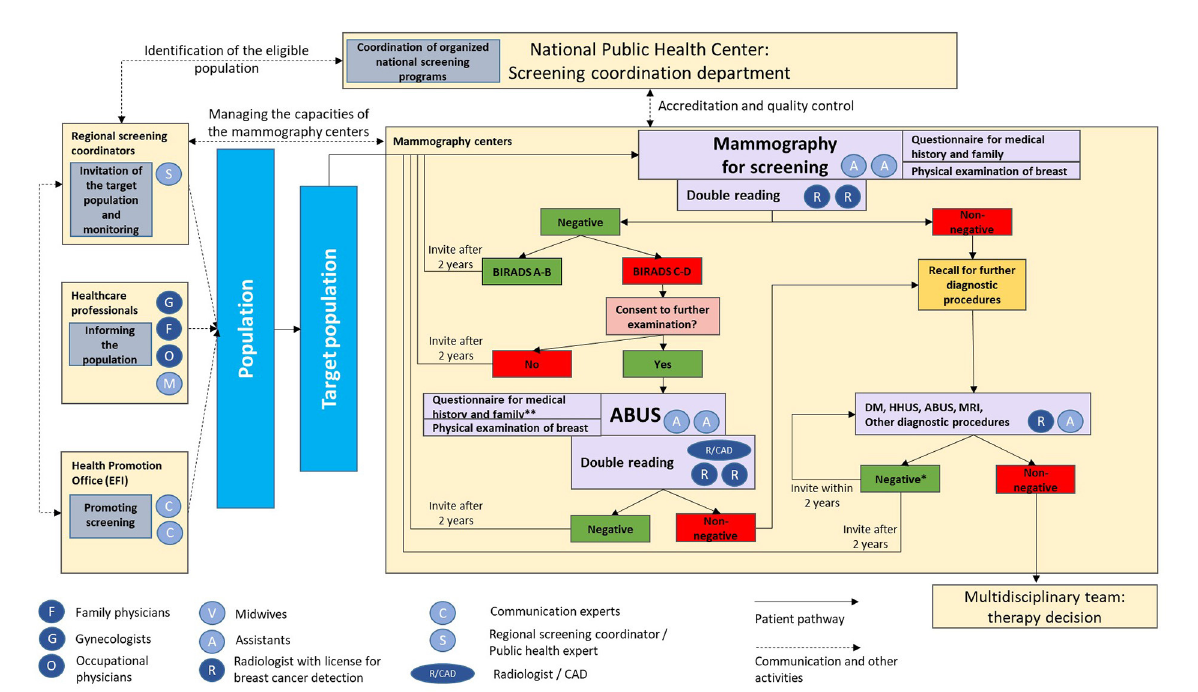
FIGURE1 Process of the screening activity with the incorporation of automated breast ultrasound. ABUS, automated breast ultrasound; BIRADS, Breast Imaging Reporting & Data System; CAD, computer-aided artificial intelligence detection; DM, digital mammography; HHUS, hand-held ultrasound; MRI, magnetic resonance imaging. *Based on the result of the first non-negative mammography; **in case of missing or outdated